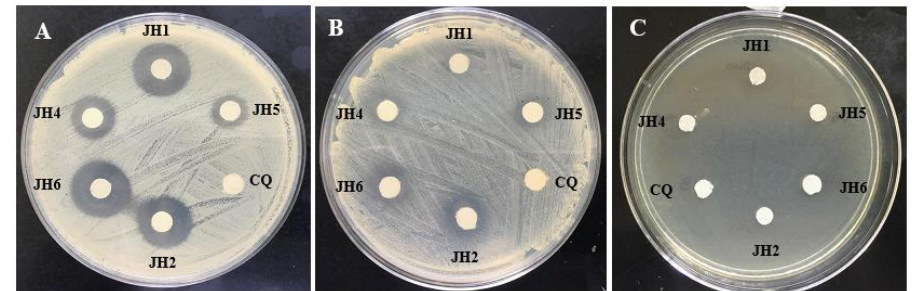
Figure 7. Antimicrobial activity test of bis-THTTs (JH1, JH2, JH4, JH5 and JH6) on different strains of Staphylococcus aureus . ( A ): S. aureus ATCC25923, ( B ): Enterotoxigenic S. aureus (SEA), ( C ): S. aureus ORSA. CQ was used as the positive control.